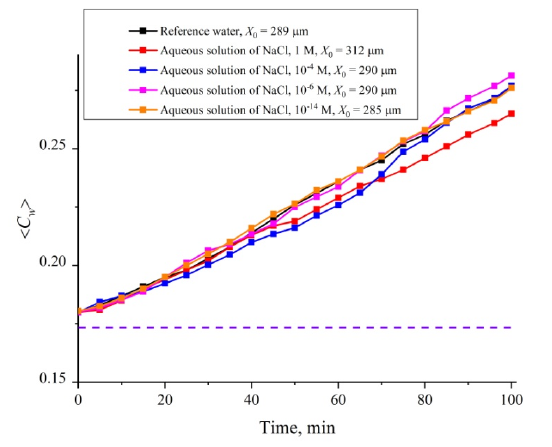
Figure 12. Average (over the distance L = 200 µ m between the windows of the cell) concentration of water (cid:104) C w ( t ) (cid:105) vs. the time of swelling for aqueous NaCl solution with concentrations of 1, 10 − 4 , 10 − 6 and 10 − 14 M. The estimates of X 0 (see Reference [24] for more detail) are also given. The dashed line is water concentration for dry Nafion.